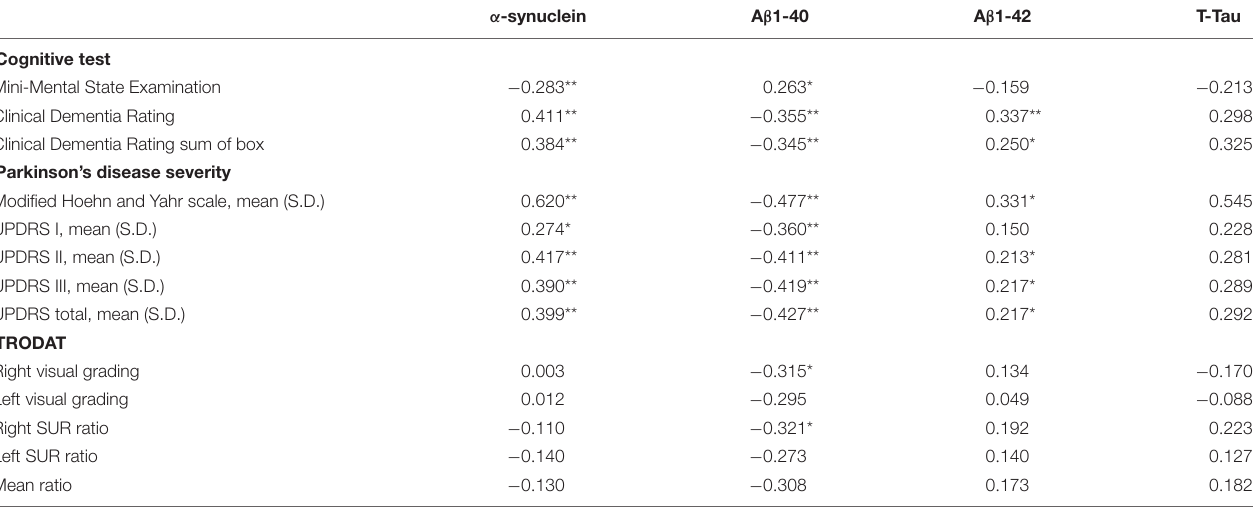
TABLE 2 | Correlation between cognitive function, Parkinson’s disease severity and plasma biomarkers.